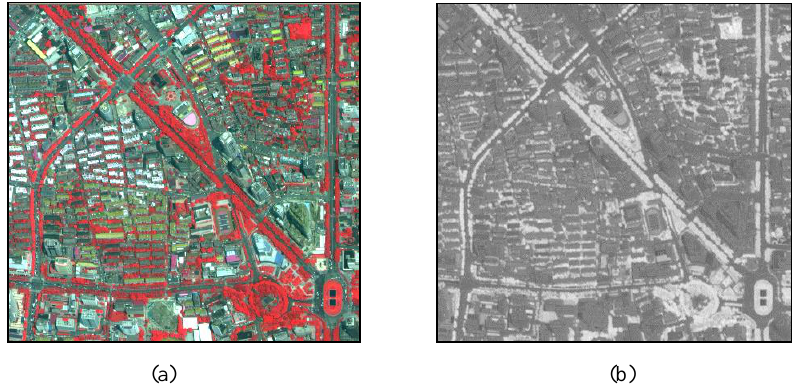
Figure 1. Test dataset ((a) is the false color image and (b) is the NDVI image)